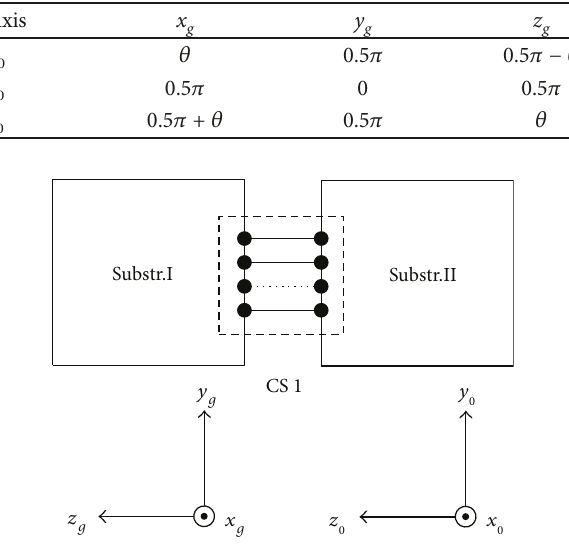
Table 3: Angle relation between the coordinates g and 0. Table 1: Material properties of the aluminum alloy.